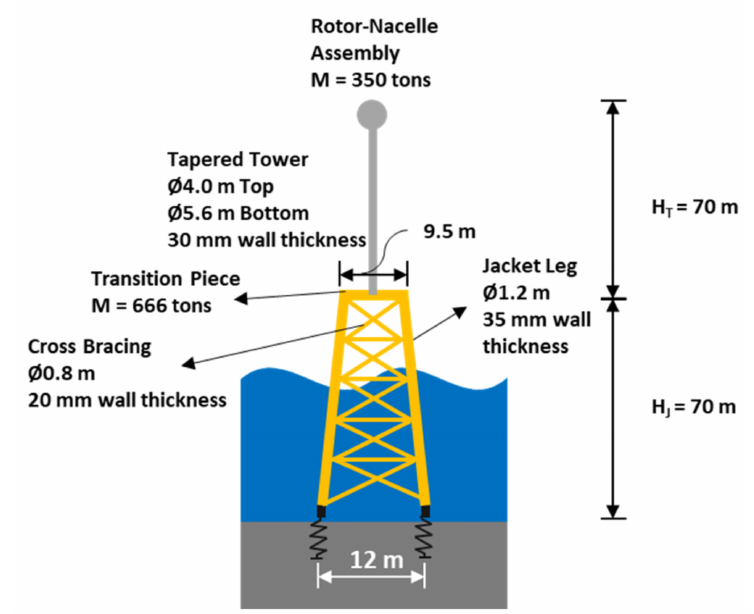
Figure 11. Example